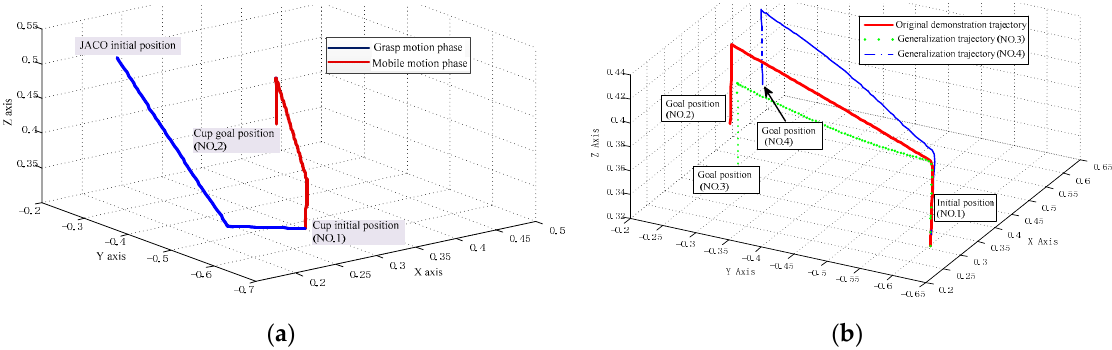
Figure 9. Demonstration and generalized trajectories drawn in Matrix Laboratory (Math Works, Natick, MA, US): ( a ) original whole demonstration trajectory; ( b ) generalized mobile motion trajectories.